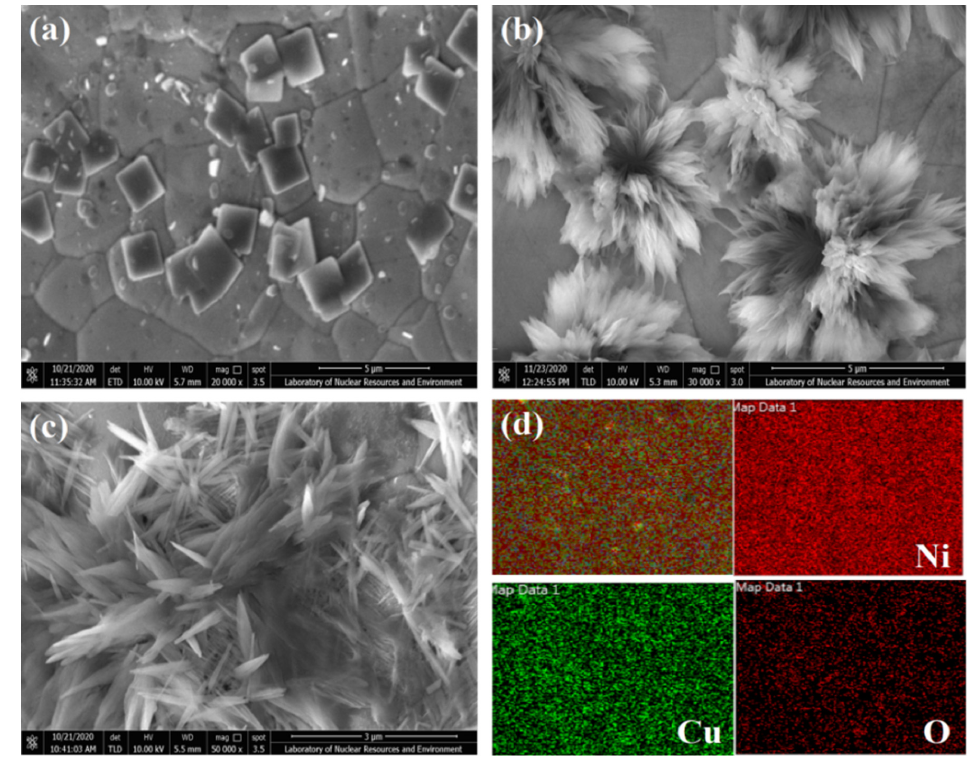
Figure 1. SEM of ( a ) NiCu ‐ NF electrode; ( b ) NiCuOOH ‐ NF electrode; ( c ) NiCuOOH ‐ NF electrode; ( d ) SEM ‐ EDX of the NiCuOOH ‐ NF electrode. ( d ) SEM-EDX of the NiCuOOH-NF XPS spectrum elucidates the change in elemental valence on the catalytic electrode.